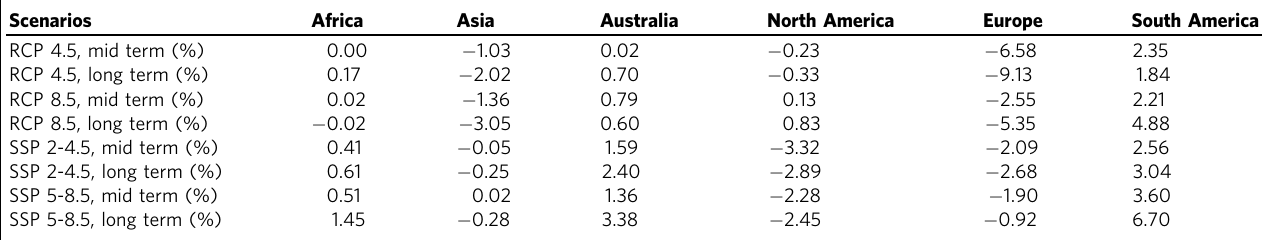
Table 1 Continental-level predicted change in the total area of soils with EC e ≥ 2 dS m − 1 in the mid- and long-term futures relative to the average of the 1904 – 1999 period under different greenhouse gas concentration trajectories.